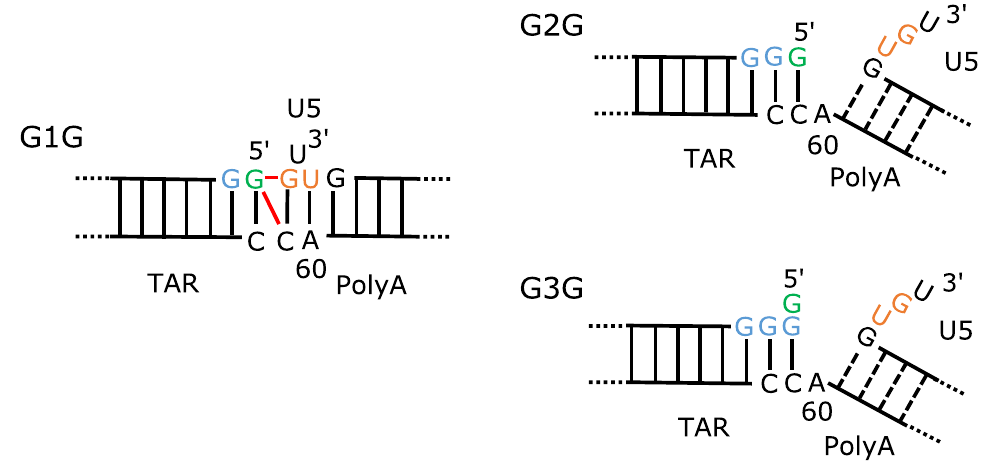
Figure 5. Schematic drawing of the conformational characteristics of the three RNA fragments. The 5 ′ G residue corresponds to the 5 ′ -Cap. Red lines indicate the observed inter-stem NOEs between the two stems, indicating the formation of the coaxial stem. The same colouring of residues is shown in Fig. 1. The G residues corresponding to the three transcription start sites and 5 ′ -Cap are coloured light blue and green, respectively. U104 and G105 at the 3 ′ -end of the PolyA stem were coloured orange. The A60 residue forms a base pair with U104 in the PolyA region for G1G. It does not pair with the U residue but stacks on the GC base pair at the end of the TAR stem for G2G and G3G. An increase of exposed residues in the U5 region will affect the structure downstream of the U5